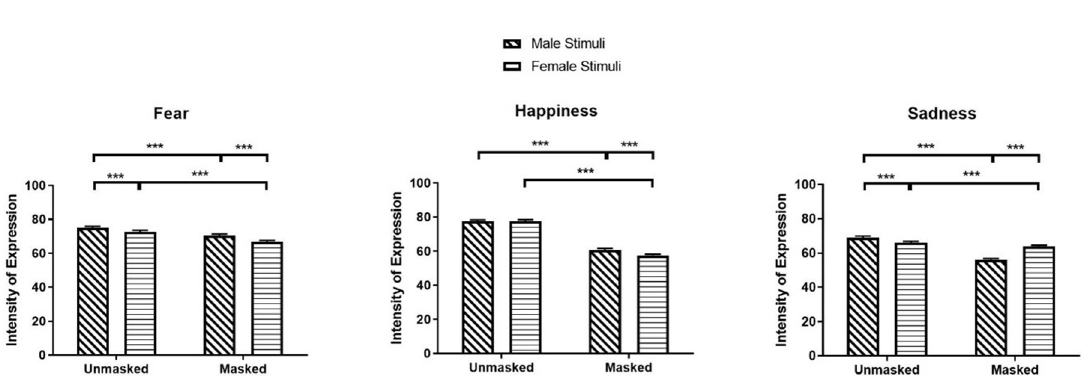
Fig 3. Intensity of expression ratings for fear, happiness, and sadness as a function of mask and stimuli sex. � p < 0.05, �� p < 0.01, ��� p <